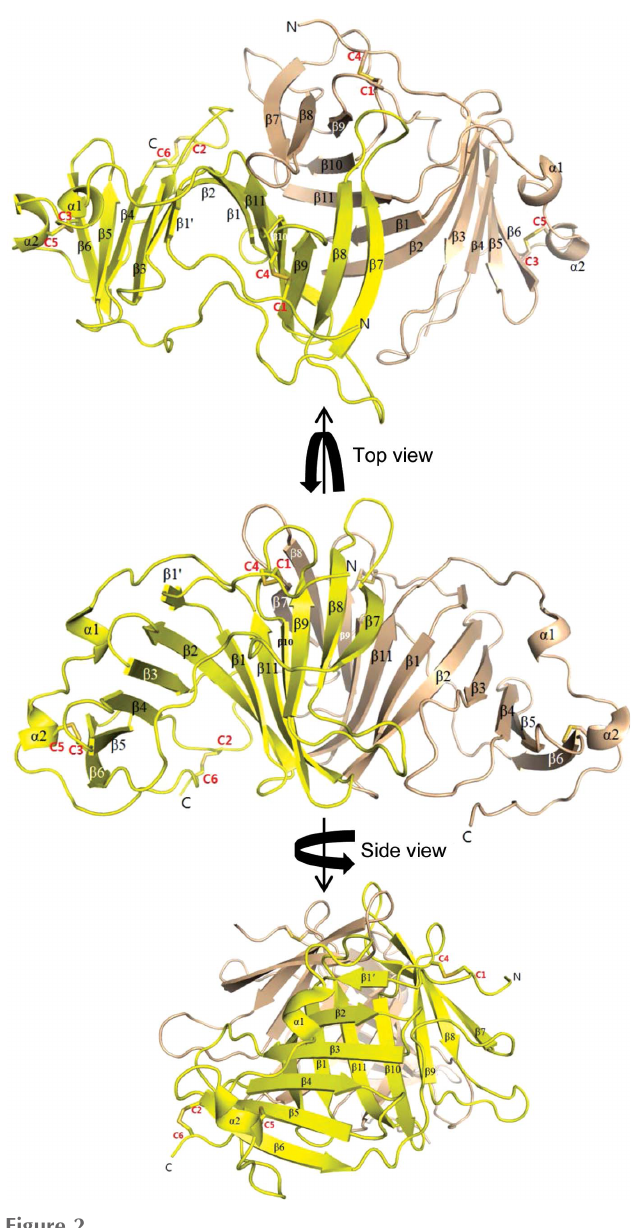
Figure 2 The overall dimeric structure of human EPDR1. Ribbon diagrams of human EPDR1 as dimers are shown as three different views. Secondary- structure elements are labeled and the locations of cysteine (C1–C6)- mediated disulfide bonds are also shown.